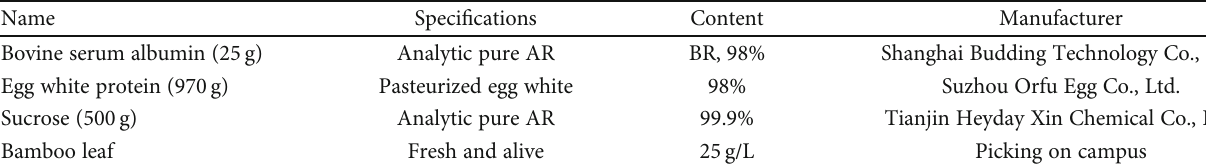
Table 1: Speci fi c parameters of organic substrates.